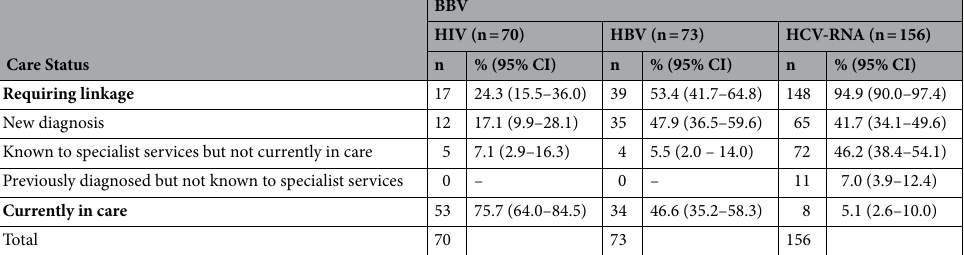
HBV. Of HBsAg-positive patients requiring LTC, 71.8% (95% CI 55.1–84.1%, n = 28) were male and the median age was 39 (range 19–63 years). Just 2.6% (95% CI 0.3–17.4%, n = 1) were White British. Approximately half (48.7%, 95% CI 33.0–64.7%,n = 19) of these individuals were White other (including Irish), 30.8% (95% CI 17.9–47.5%, n = 12) were Black British or Black other, 10.3% (95% CI 3.7–25.2%, n = 4) were Mixed or any other ethnicity, 7.7% (95% CI 2.4–22.2%, n = 3) were Asian British or Asian other. Again, neither age, sex nor ethnic- ity were crudely associated with requiring LTC (all p > 0.05). Most HBsAg-positive patients requiring LTC were from an area of high prevalence (HBsAg prevalence of more than 8% 26 ) (87.2%, 95% CI 71.8–94.8%, n = 34). HCV. As with HIV and HBV, the majority of HCV RNA-positive patients requiring LTC were male (73.6%, 95% CI 65.9–80.2%, n = 109), with a median age of 41 (interquartile range (IQR) = 35—48). In contrast to HIV and HBV, 87.8% (95% CI 81.4–92.2%, n = 130) were White British, 9.4% (95% CI 5.6–15.4%, n = 14) were White other (including Irish), 1.4% (95% CI 0.3–5.3%, n = 2) were Black British or Black other, 0.7% (95% CI 0.1–4.7%, n = 1) were of Mixed ethnicity and a further 0.7% (95% CI 0.1–4.7%, n = 1) were Asian British or Asian other. As with the other BBVs, neither age, sex or ethnicity were crudely associated with requiring LTC (all p > 0.05). The majority of RNA-positive patients were a current person who inject drugs (PWIDs) (56.8%, 95% CI 48.6–64.6%, n = 84), while a further quarter had previously injected drugs (25.7%, 95% CI 19.2–33.4%, n = 38). Linkage to care pathways. HIV. 16/17 (94.1%, 95% CI 62.7–99.3%) HIV Ab/Ag positive patients were successfully linked to care (Fig. 2A). 5/17 HIV Ab/Ag positive patients diagnosed within the ED (29.4%, 95% CI 11.5–57.1%) were known to specialist services but not in care at the time of their ED visit; four of these five patients (80.0%, 95% CI 11.1–99.21%) successfully linked to care. All those newly diagnosed in ED were linked to care. Twelve (70.6%, 95% CI 42.9–88.5%) patients linked to care commenced antiretroviral treatment (ARVs) within six months; of the remaining four individuals, three were known to specialist services but had previously disengaged. Eleven patients (64.7%, 95 CI 37.7–84.8%) achieved viral suppression (HIV viral load < 200 copies/ ml) within six months on treatment. One patient died before completing six months on ARVs. HBV. 27 of 39 HBsAg-positive patients (69.2%, 95% CI 52.5–82.1%) were successfully linked to care (Fig. 2B). Of the twelve patients not linked, four (33.3%, 95% CI 10.9–67.1%) lived out of area, seven (58.3%, 95% CI 26.7–84.3%) were newly diagnosed with HBV for the first time within the ED and one (8.3%, 95% CI 0.8–50.1%) was known to specialist services but had previously disengaged. Three of the 27 individuals (11.1%, 95% CI 3.3–31.1%) who were successfully linked to care had previously been linked to care but had disengaged by the time of their ED attendance, and were therefore re-engaged because of their ED testing. HCV. Only 58 of 148 patients requiring LTC (39.2%, 95% CI 31.6–47.4%) were seen in clinic or as an inpatient (Fig. 2C). In total, one quarter (25.0%, 95% CI 18.6–32.7%, n = 37) of HCV RNA-positive patients requiring ated with commencing treatment was PWID status, with current PWIDs being significantly less likely to start treatment than those not currently not using drugs (odds ratio = 0.11, 95% CI 0.03–0.36, p < 0.001). Two-thirds (64%, n = 58) of those patients who did not engage with treatment within six months were current PWIDs. In contrast, current PWIDs were underrepresented within the population who successfully commenced